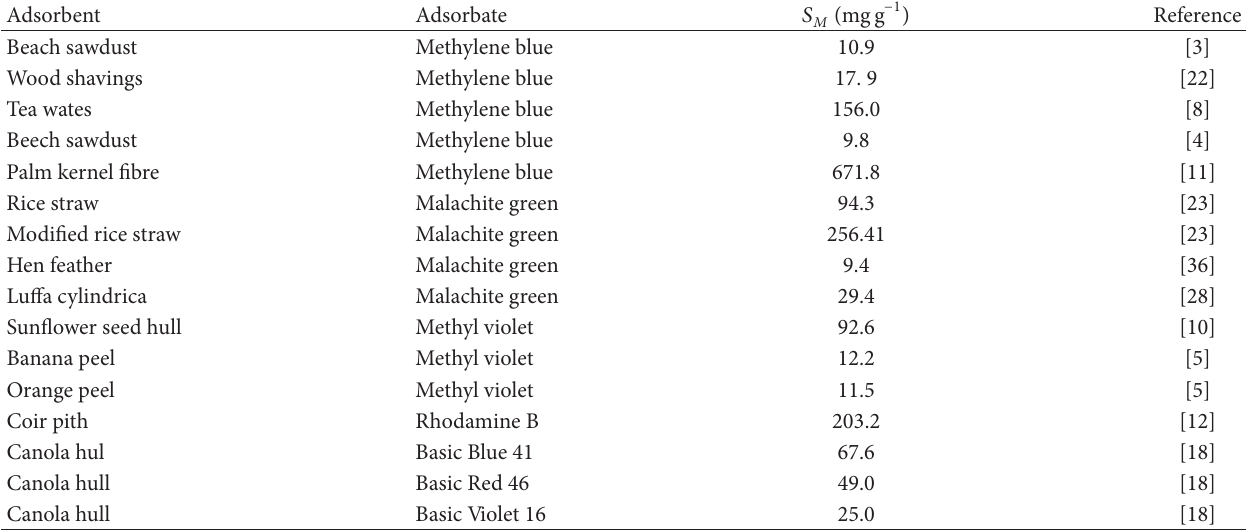
F 4: Micrograph of PC (a), PC-� (b), OC (c), and OC-� (d) (magni�cation: �100). T 4: Reported basic dye adsorption capacities for agricultural